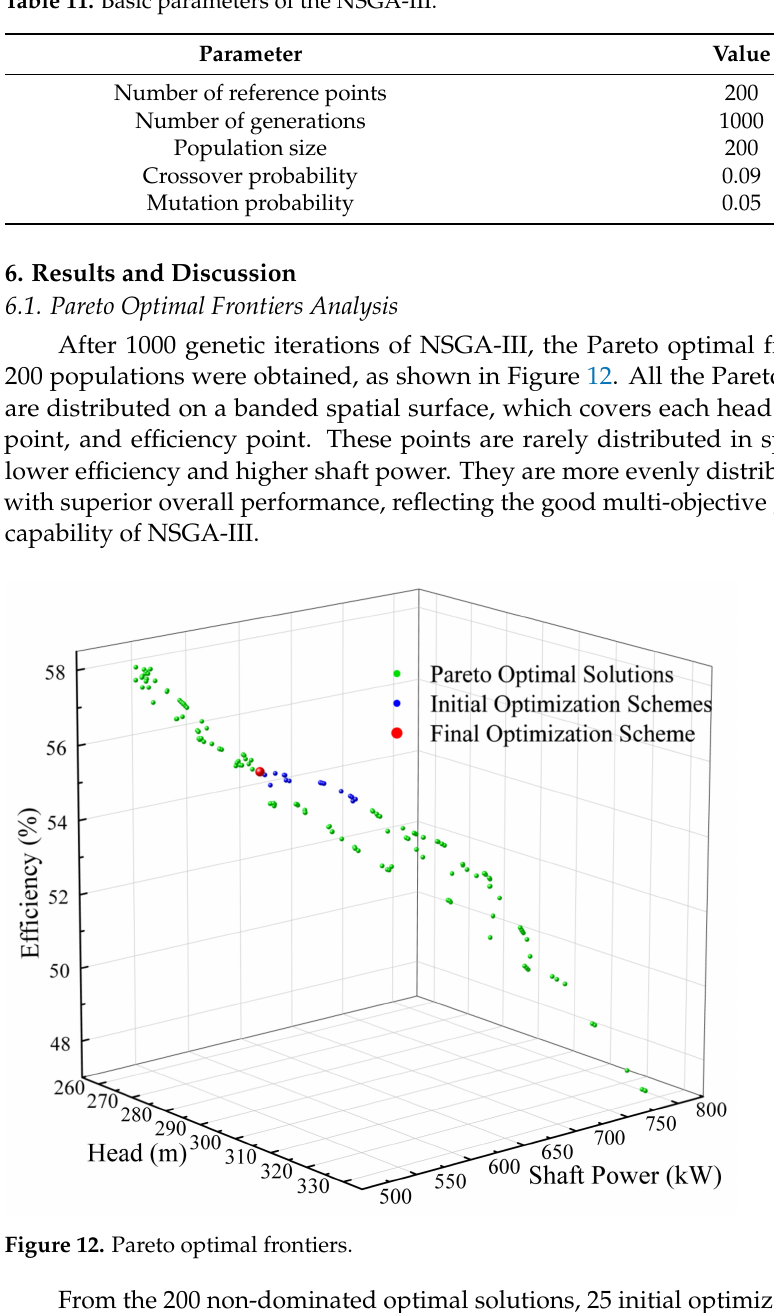
Table 11. Basic parameters of the NSGA-III.